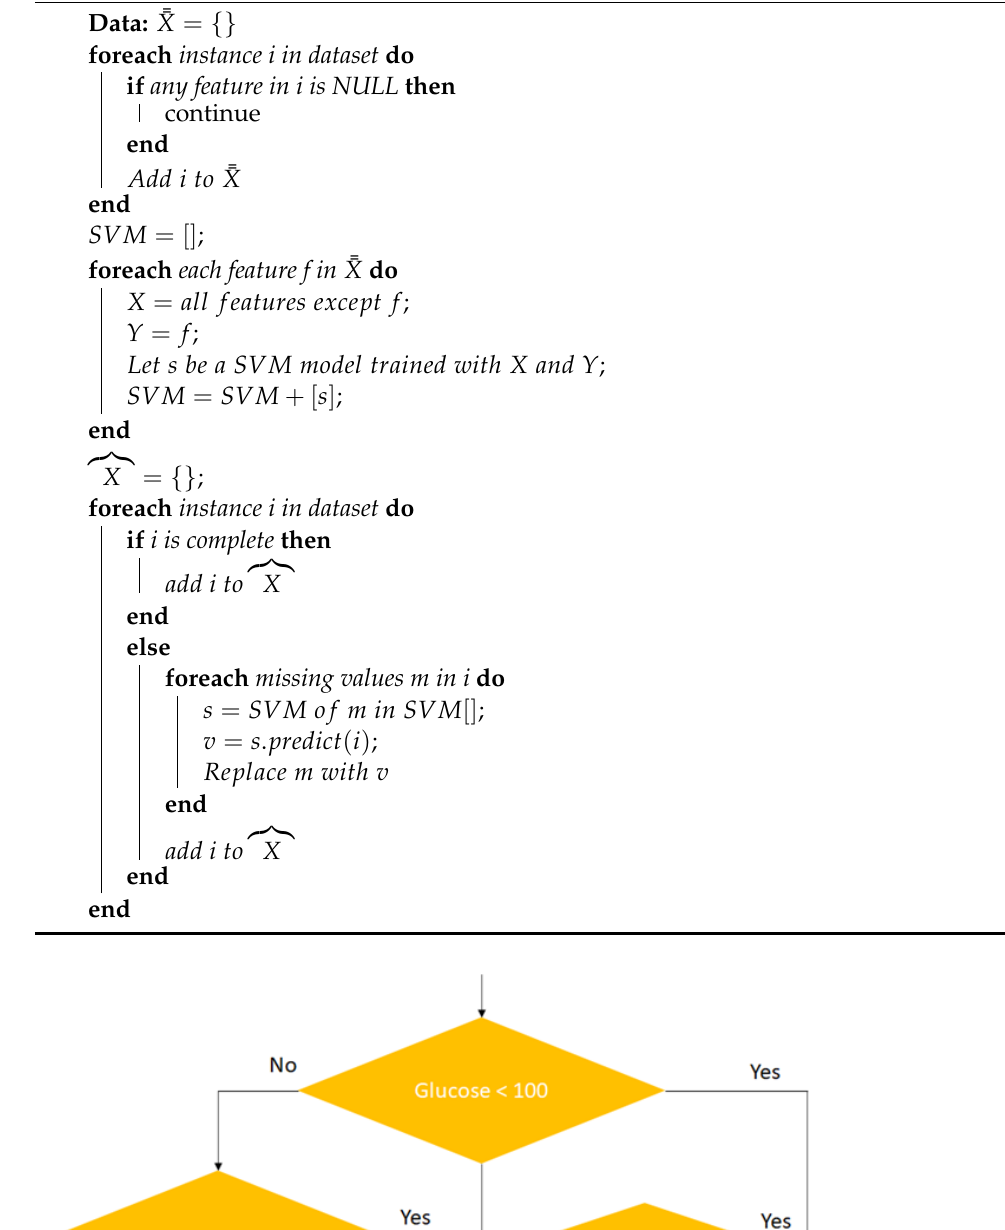
Algorithm 1: SVM Imputation